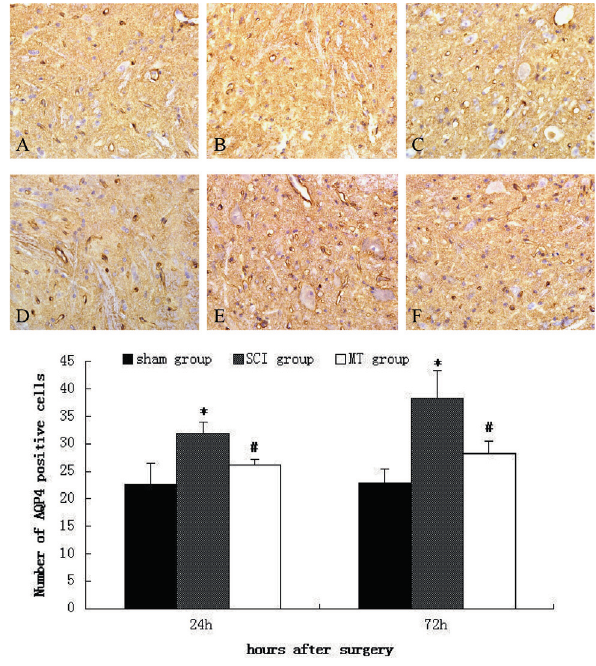
Fig. 1. Spinal cord water contents at 12, 24, 48 and 72 h after injury. The figure shows a significant increase in the spinal cord water content in SCI group compared with that of Sham group at 12, 24, 48 and 72 h after injury, while a significant reduction was observed in MT group compared with that of SCI group at 24, 48 and 72 h after injury. Data present mean ± SD (n=5, * P <0.05 between Sham group and SCI group, # P <0.05 between MT group and SCI group).